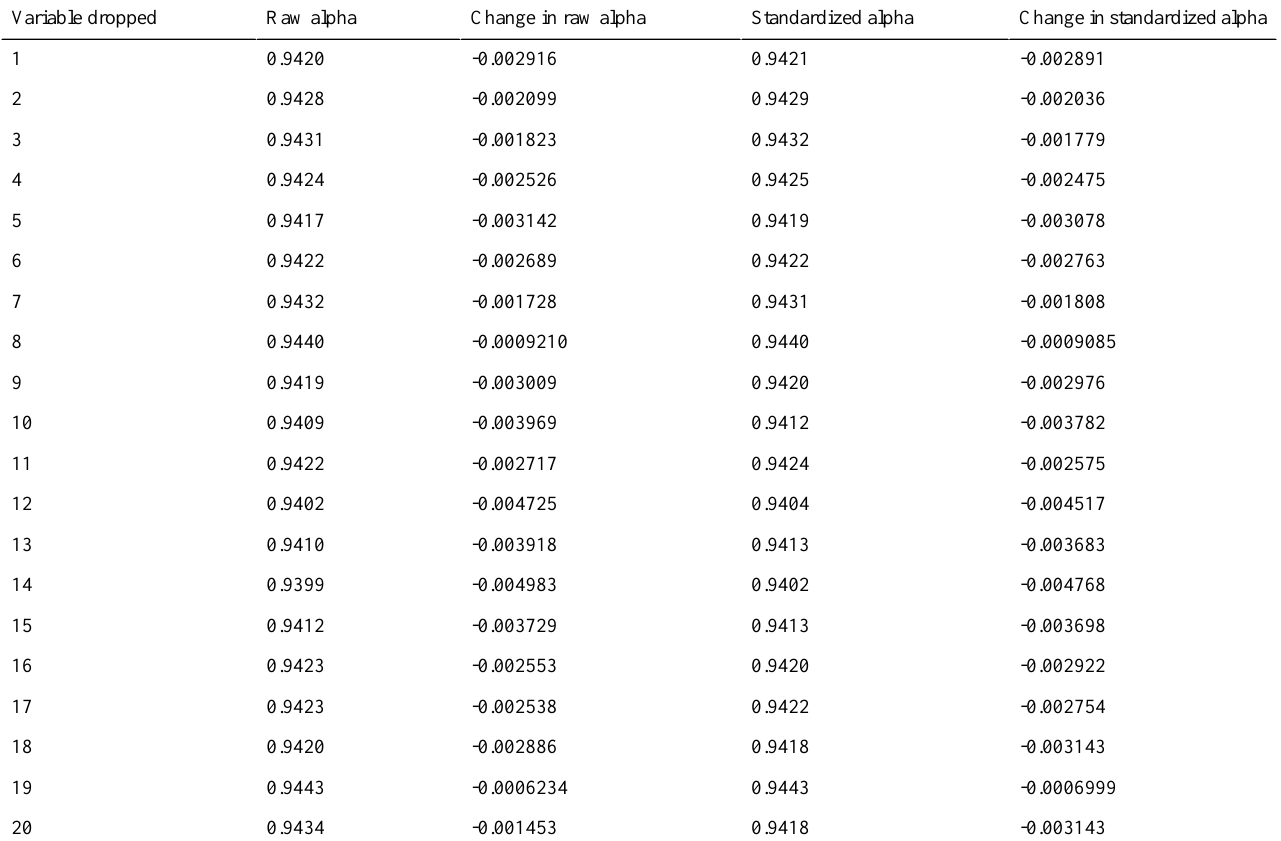
Table 3. Cronbach alpha coefficient when one item is